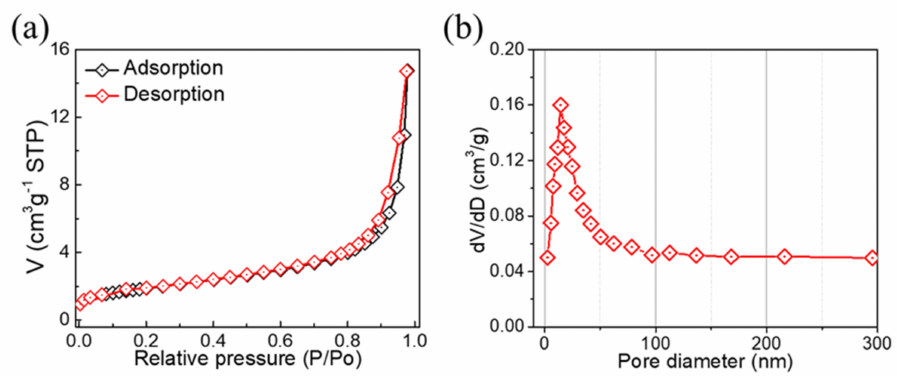
Figure 4. ( a ) N 2 adsorption/desorption isotherm; ( b ) Typical pore size distribution of TiO 2